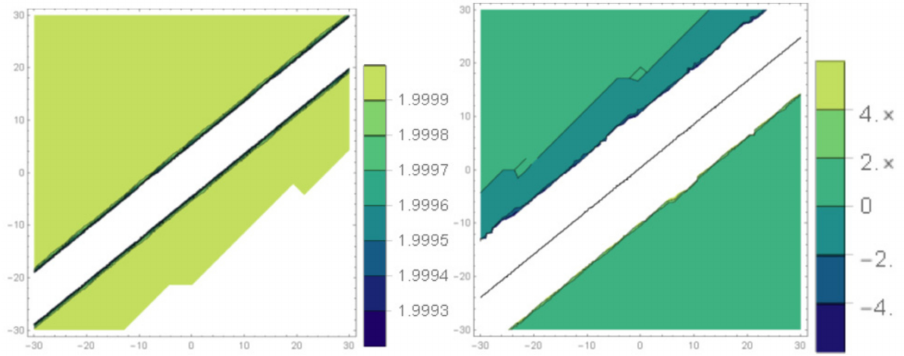
Figure 12. The contour graphs of Equation (24) under the values of ε = 0.4, − 30 < x < 30, − 30 < t < 30.